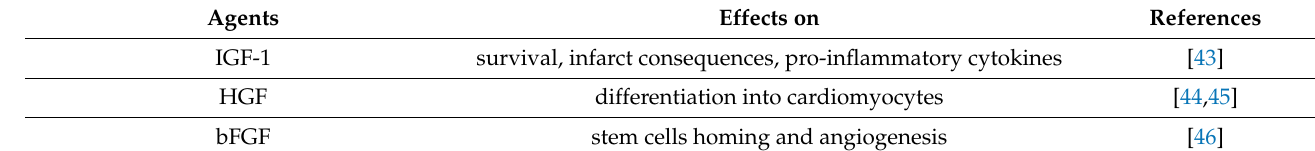
Table 1. MSC preconditioning with pharmacological and chemical